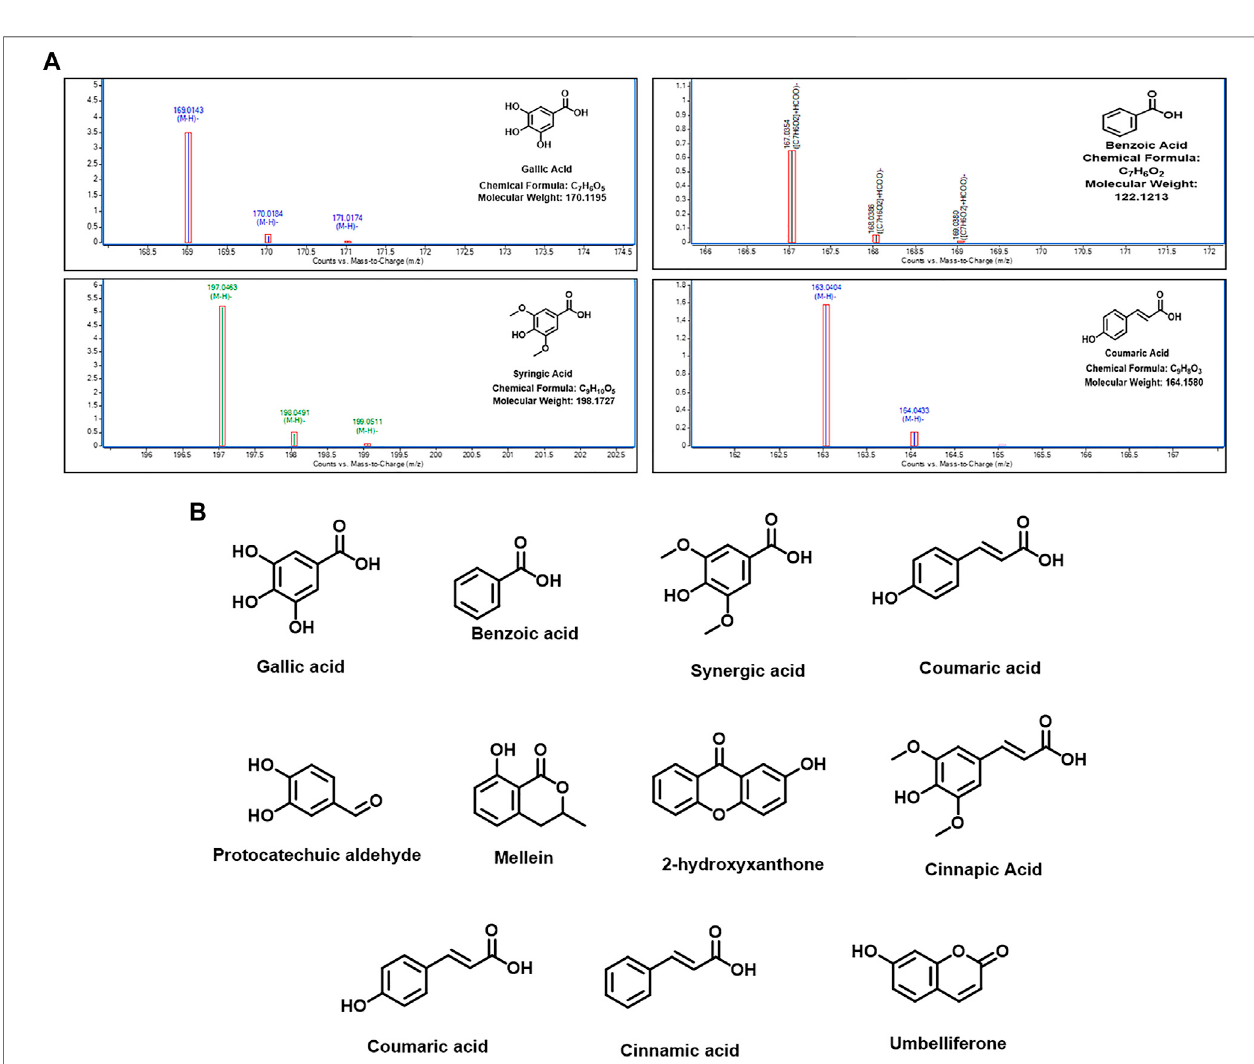
FIGURE6| Identi fi edmetabolitehitsinthehydroalcoholicextractanditsfractionF1intheLC-QTOF-ESI-MSanalysis. (A) MajormetabolitespresentinbothDPand F1. (B) Chemical compound structures present in both positive and negative mode in the LC-QTOF-ESI-MS.